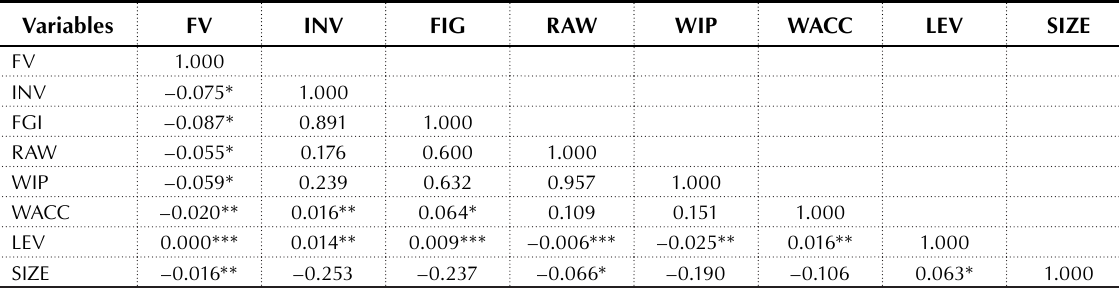
Table 4. Correlation matrix